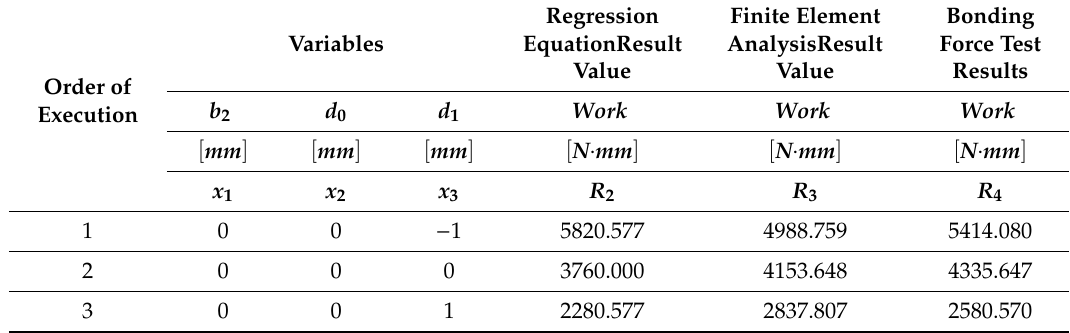
Table 7. Results of geometry variable modification and bonding force tests to verify the regression